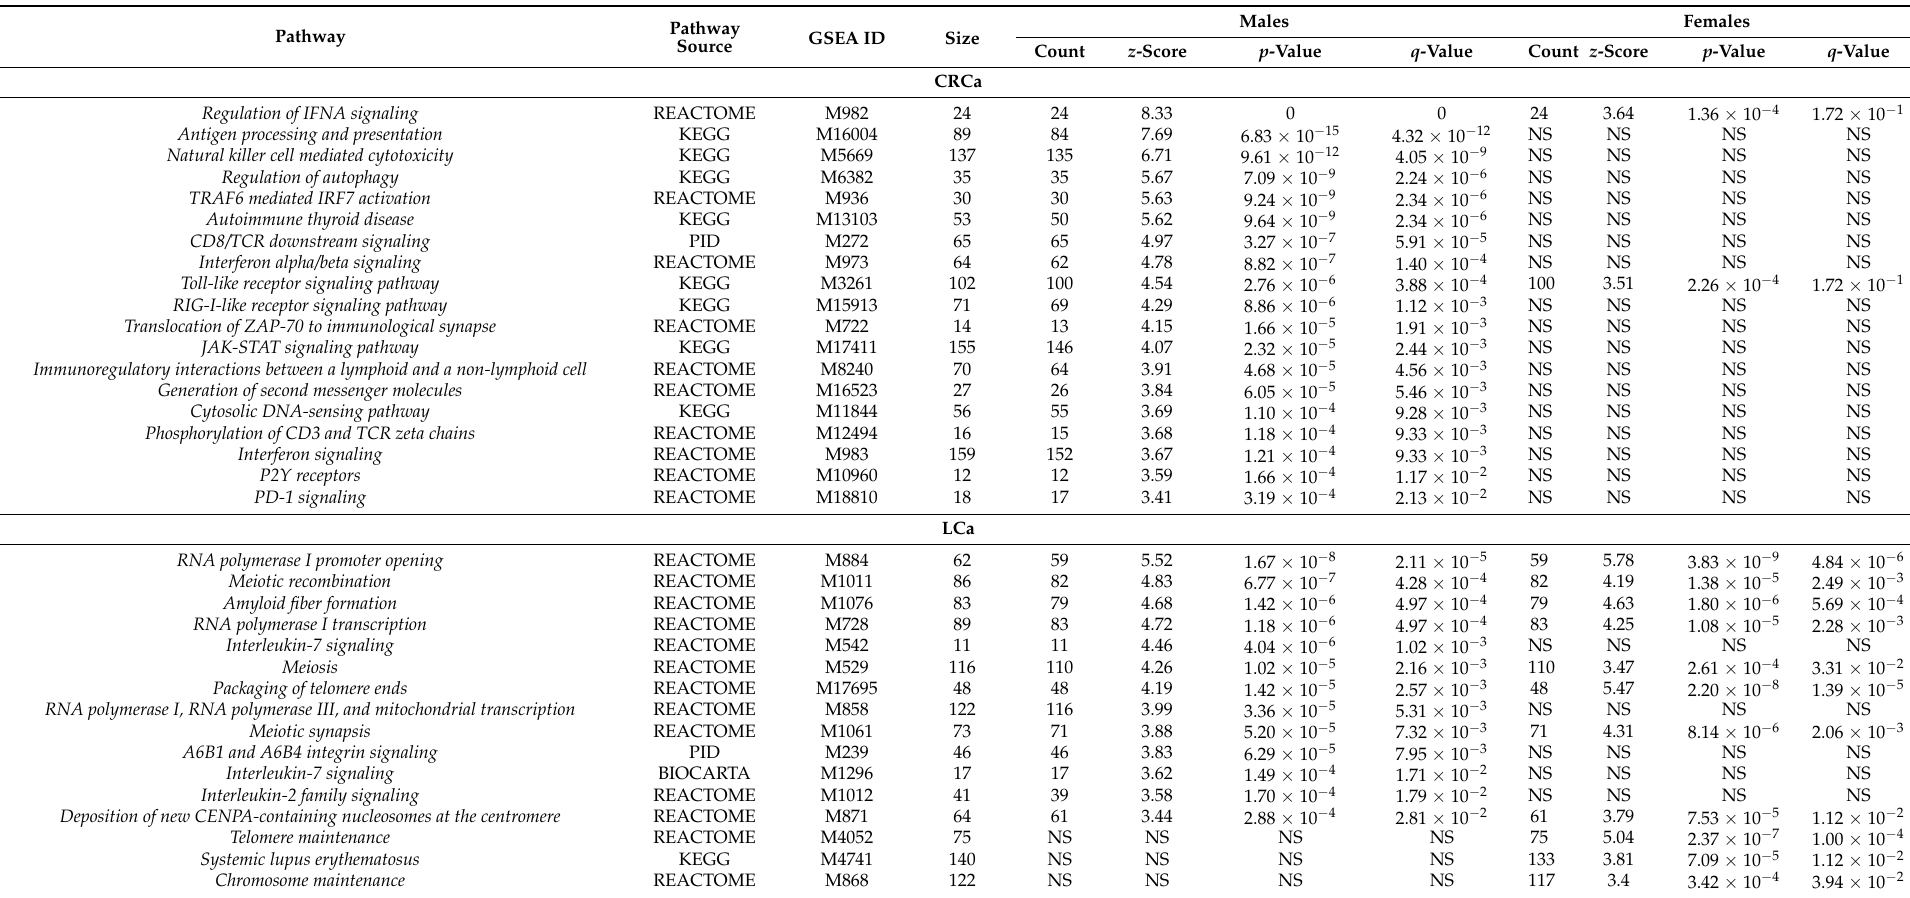
Abbreviations: CRCa = colorectal cancer; LCa = lung cancer; GSEA = Gene Set Enrichment Analysis Platform; KEGG = Kyoto Encyclopedia of Genes and Genomes [53]; BIOCARTA = BIOCARTA pathways [54]; PID = Pathway Interaction Database [55]; REACTOME = REACTOME pathway knowledgebase [56]; Size = number of genes in the pathway; Count = number of enriched genes in the pathway; NS =